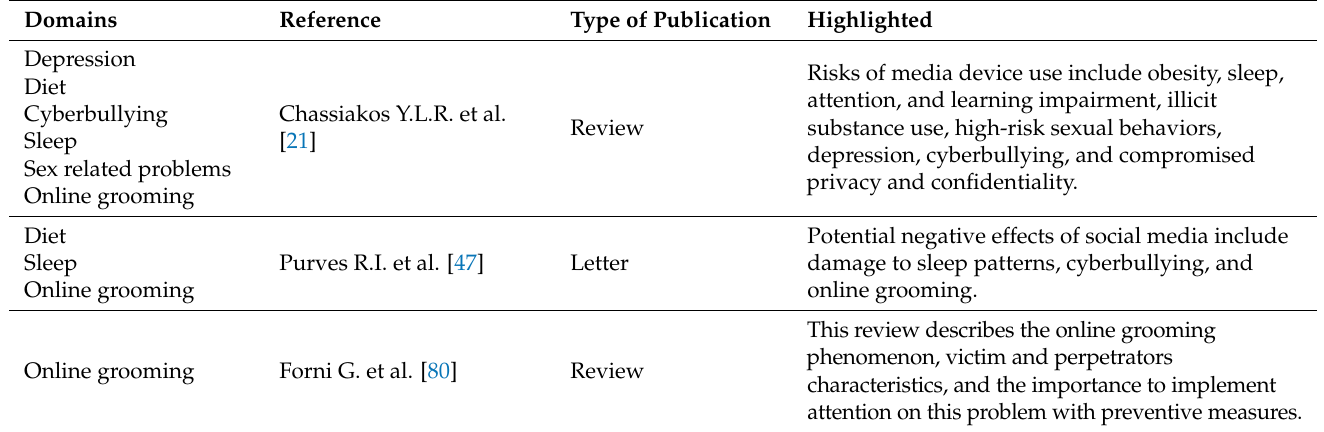
Table 13. Social media and online